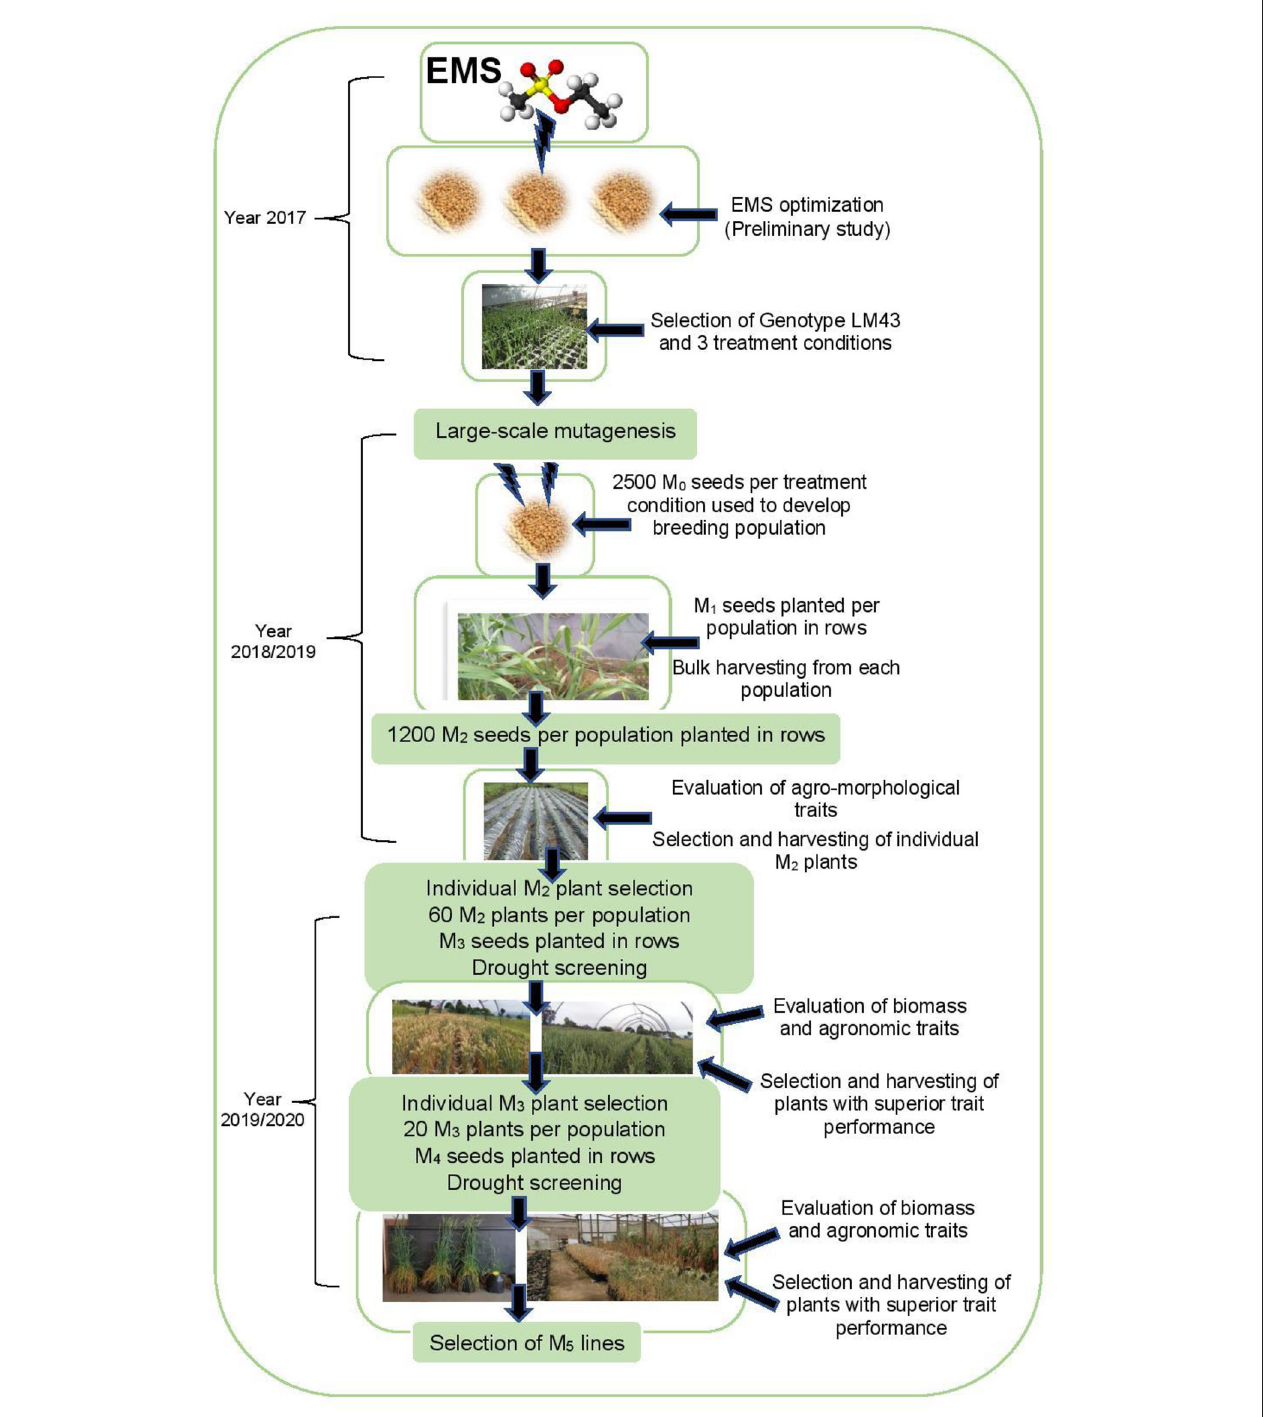
FIGURE 1 | Development of wheat populations using three EMS treatments between 2017 and 2020.